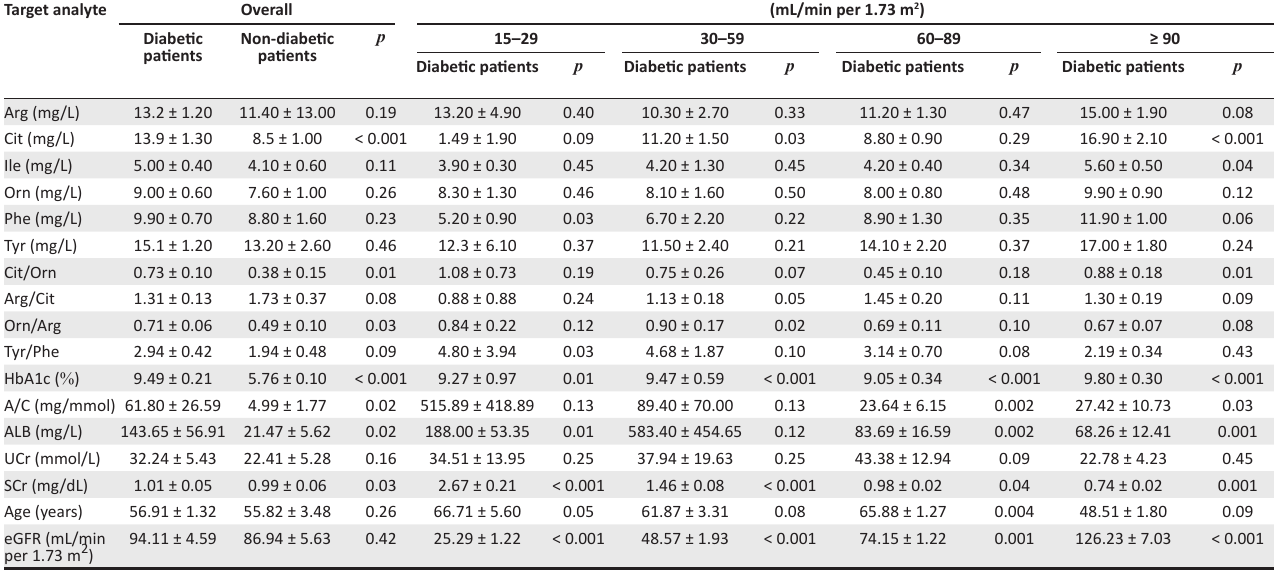
TABLE 4: Differences in amino acid concentrations and clinical parameters between diabetic and non-diabetic patients with declining estimated GFR, Johannesburg, South Africa, November 2019 to January 2021. Target analyte Overall Diabetic